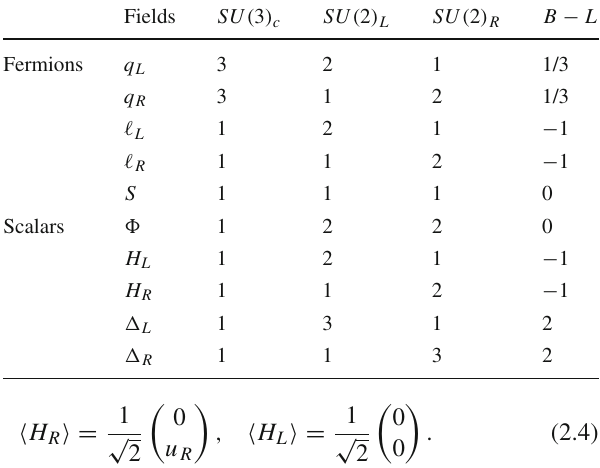
Table1 Particlecontentofleft–righttheorieswithtype-IIseesawdom- inance